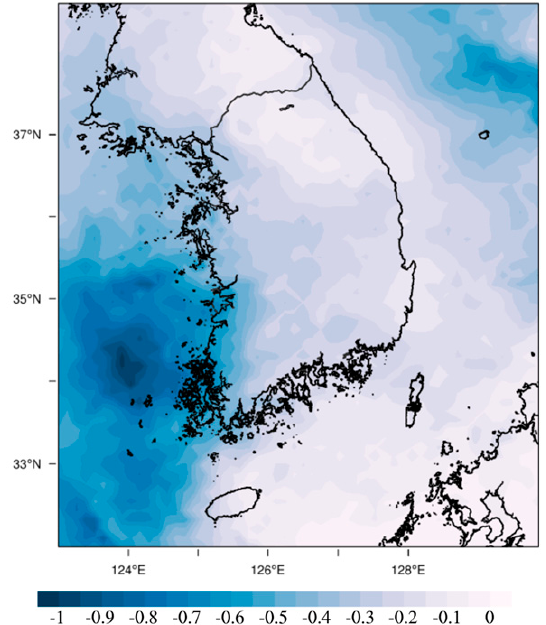
Figure 6. The changes in aerosol direct radiative effects (ADRE, Wm − 2 ) in South Korea due to the reduction of SO 2 emissions from foreign sources (R_FSO2–BASE).